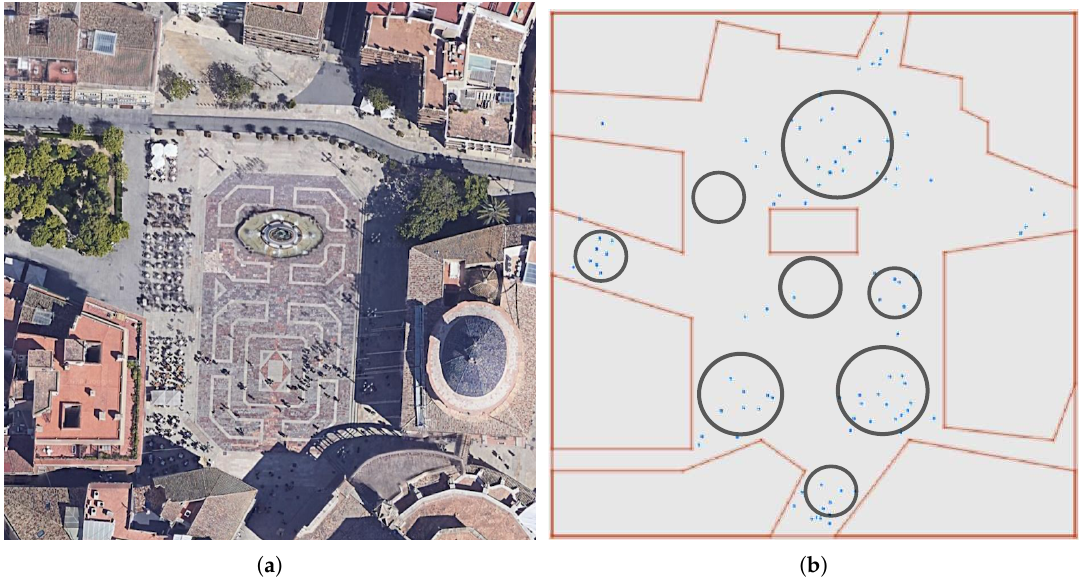
Figure 1. Plaza scenario, located in Valencia, Spain. ( a ) Aerial view of the plaza. It is a very touristic square, with dimensions of approximately 120 × 120 m. The walkable space is surrounded by buildings, with a fountain in the centre and seven entrances. ( b ) Design of the PedSim scenario, showing the walking pedestrians (small blue points) and the points of interest delimited by black